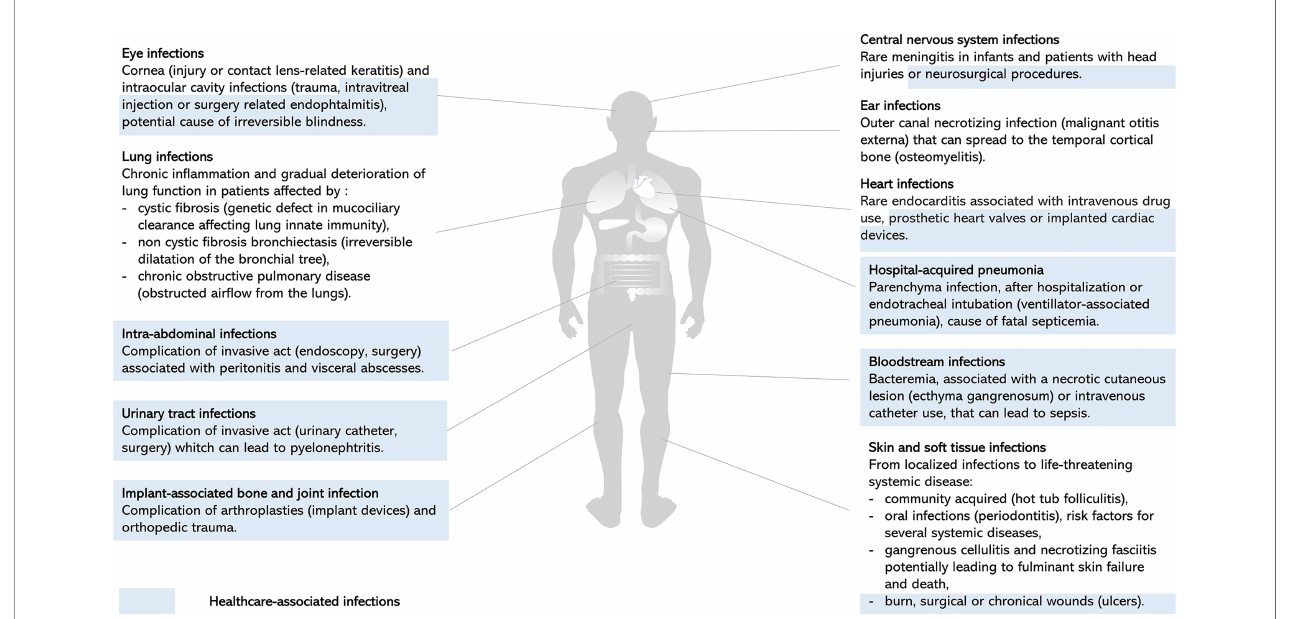
FIGURE 1 | Clinical manifestations of P. aeruginosa infections. Representation of human body site infections and main clinical manifestations of P. aeruginosa. Healthcare-associated infections highlighted in blue illustrate the signi fi cant burden of P. aeruginosa on invasive acts, surgery, and device use, resulting in local or systemic complications (Wu et al., 2011; Dando et al., 2014; Gahlot et al., 2014; Elborn, 2016; Durand, 2017; Newman et al., 2017; Arsovic et al., 2020; Ramireddy et al., 2020; Chai and Xu, 2020; Shukla et al., 2020; Jean et al., 2020; Montravers et al., 2020; Cerioli et al., 2020; Shrestha et al., 2021; Vieira et al., 2016; Hauser and Ozer,